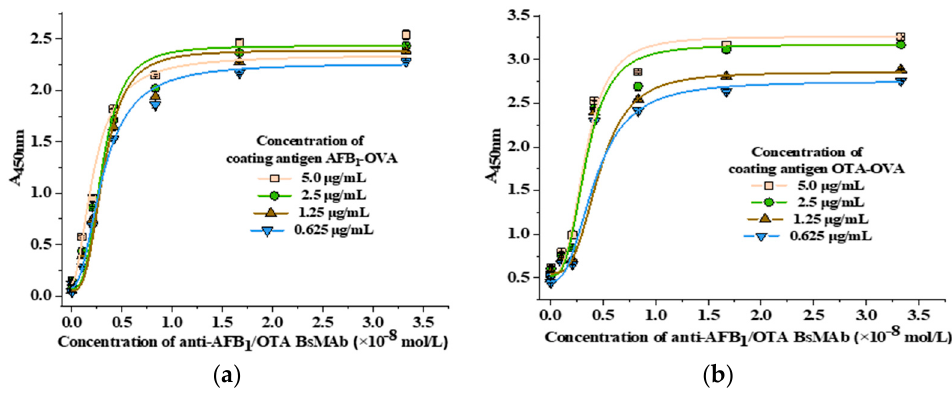
Figure 5. The affinity constants (Ka) of anti-AFB 1 /OTA BsMAb: ( a ) AFB 1 ; ( b ) OTA.